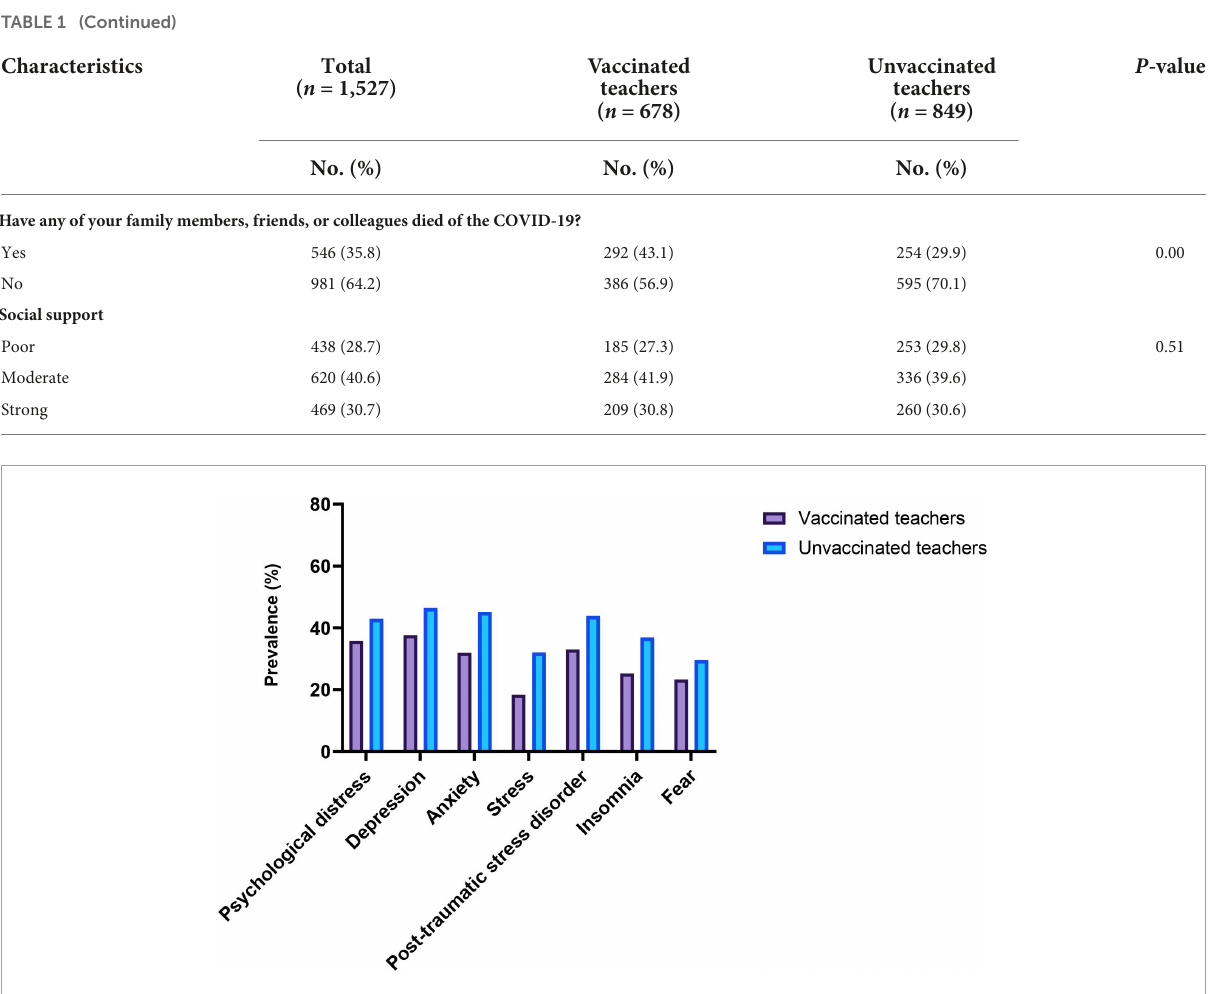
FIGURE1 Prevalence of mental health outcomes among vaccinated and unvaccinated teachers against COVID-19